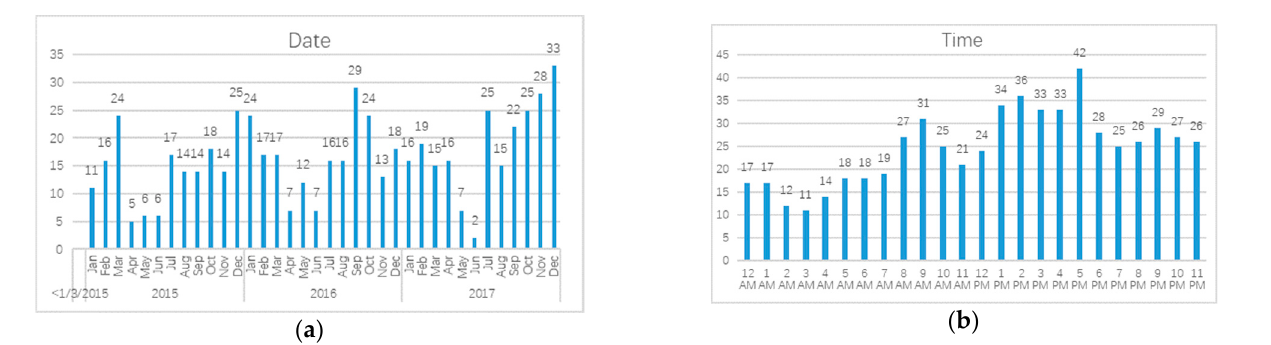
Figure 2. ( a ) The distribution of accident date. ( b ) The distribution of accident time . AM and PM in ( b ) are “ante meridiem” and “post meridiem” which means time period before noon (0:00–12:00) and after noon (12:00–24:00).